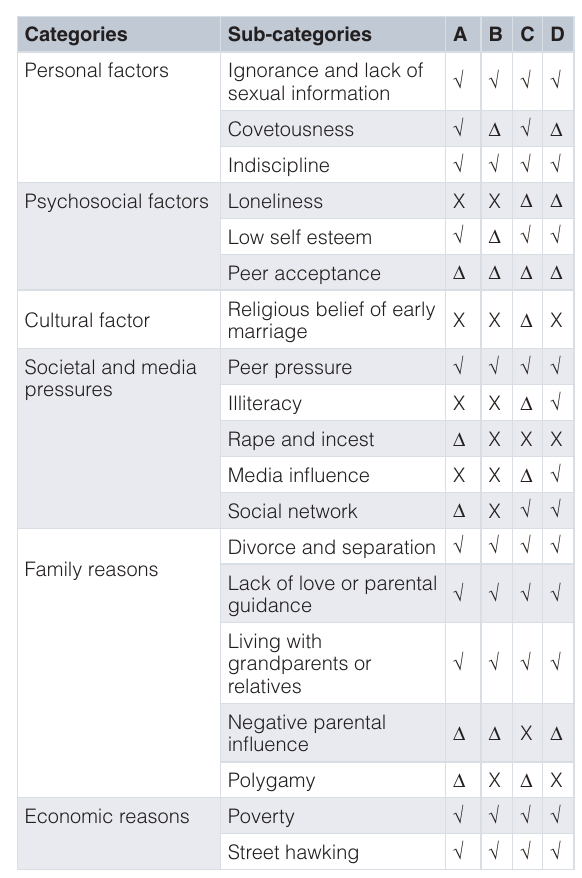
Table 4. Participants’ perceived causes of teenage pregnancy (n = 80). To compare the responses of